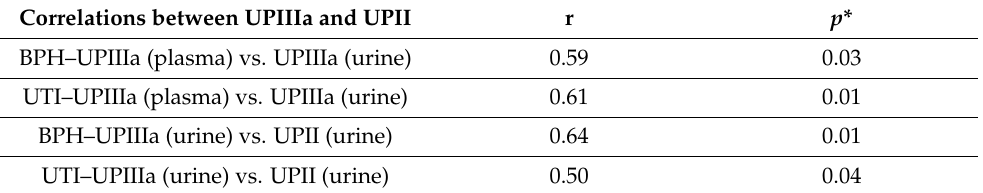
Table 4. Correlations between UPIIIa and UPII in patients with selected urological diseases. Correlations between UPIIIa and